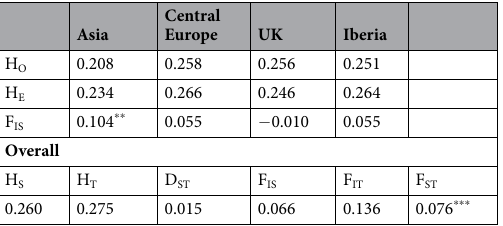
Table 1. Basic population parameters generated by genetic diversity analysis calculated according to Nei (1977) 61 . The statistical significance of F IS and F ST were derived from χ 2 tests with one degree of freedom as χ 2 = NF IS2 , and χ 2 = 2NF < 0.01 ); *** ( P < 0.001 ST , respectively; ** ( P